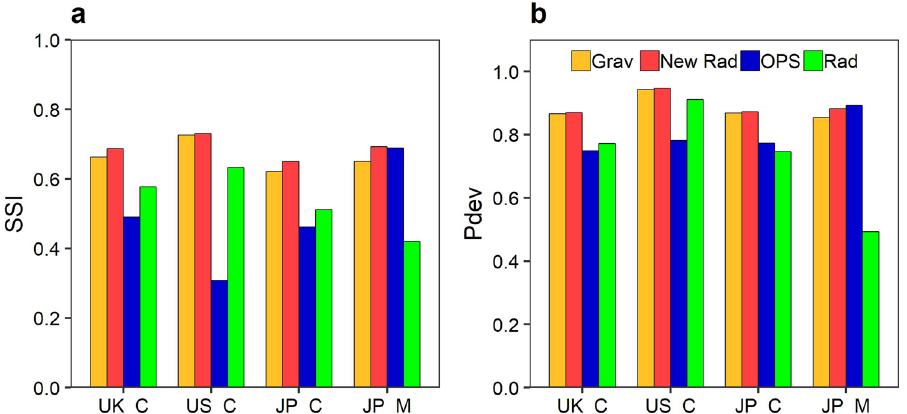
Figure 6. Comparison of accuracy of model fitting; ( a ) predictive accuracy of models based on SSI (Sørensen similarity index). ( b ) Same as ( a ) but based on Pdev (Percent deviance explained). Grav, New Rad, OPS, and Rad indicate the production-constrained gravity model, the kernel-based radiation model, the OPS model, and the original radiation model,